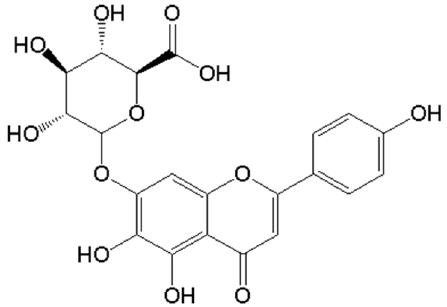
Figure 1. The structure of scutellarin.